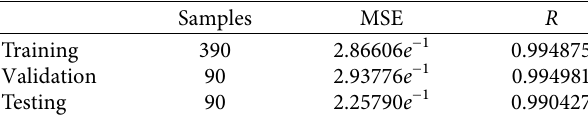
Table 2: Results of ANN